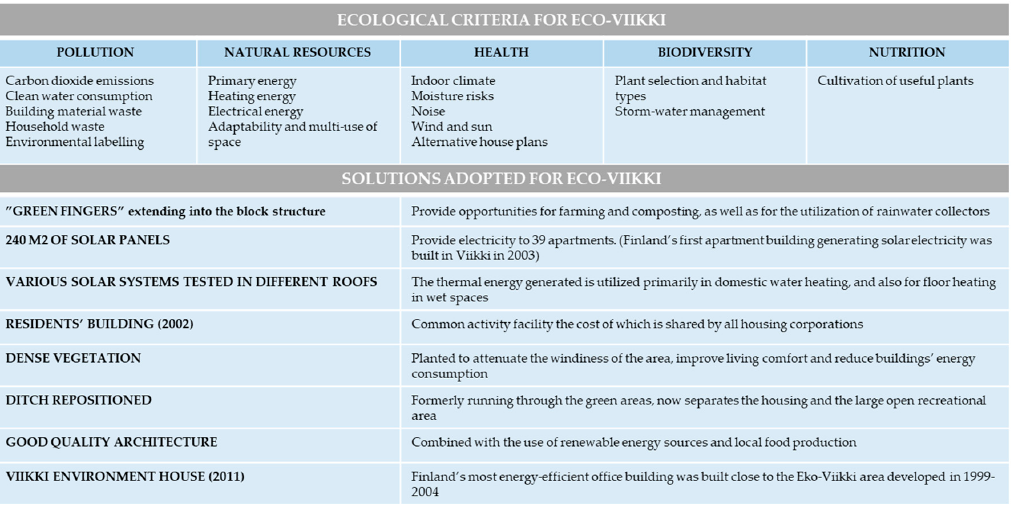
Figure 2. Ecological building criteria for Eco-Viikki and main solutions adopted. Own elaboration based on content in [29].